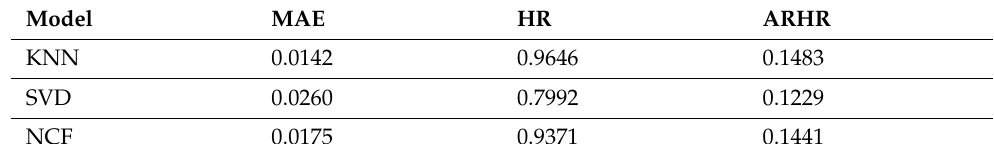
Table 3. Performance evaluation of different models (in units) in 80:20 training–testing ratio. Table 1. Performance evaluation of different models (in units) in 60:40 training–testing scenario. Model Model